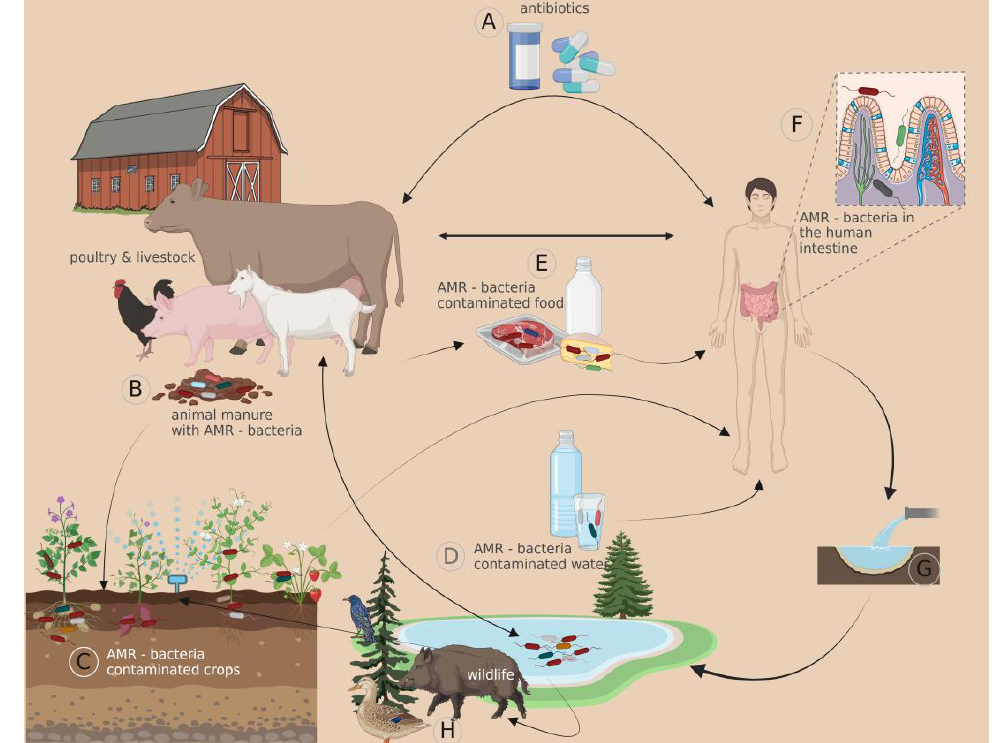
Figure 2. The role of livestock in the spread of antibiotic resistance in the environment. The administration of antibiotics to both human and animal populations favours the spread of resistance-associated genes in the natural environment, hence maintaining an ongoing reciprocal transmission, regardless of host origin. Created with Biorender.com and partly generated using Servier Medical Art and Twinkl.co.uk.